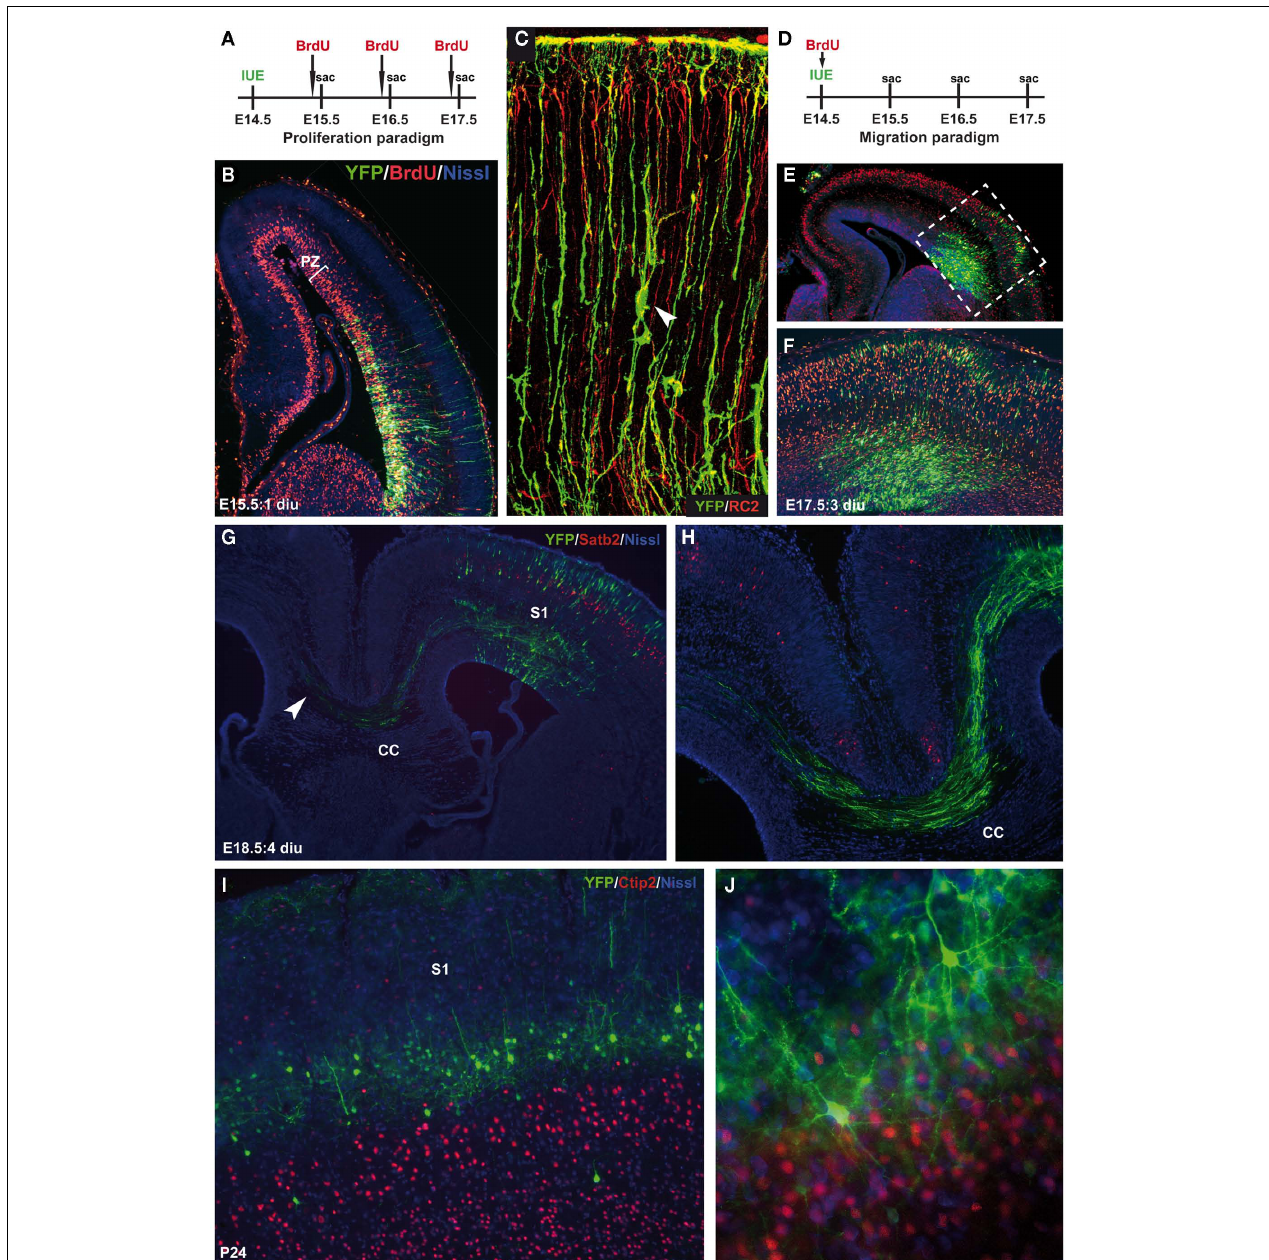
position within the cortical plate (CP) combined with aYFP control construct (green), counterstained with fluorescent Nissl (blue) 3days after IUE (3 diu). As soon as theYFP-positive neurons become post-mitotic they start to migrate and can be double labeled with BrdU (yellow). (F) Is an enlargement of the boxed area in (E) . (G) E18.5 coronal section showing anYFP-labeled (green) somatosensory cortex (S1) projecting toward the other hemisphere through the corpus callosum (CC) counterstained with superficial layer marker Satb2 (red) and fluorescent Nissl (blue). (H) Is an enlargement of the projections through the CC in (G) . (I) P24 coronal section showing YFP-positive pyramidal neurons (green) in layer IV of the S1 on top of the layer V marker Ctip2 (red). (J) Network formation ofYFP-positive pyramidal neurons with extended dendritic branches and axonal projections. Counterstained with Ctip2 (red) en fluorescent Nissl